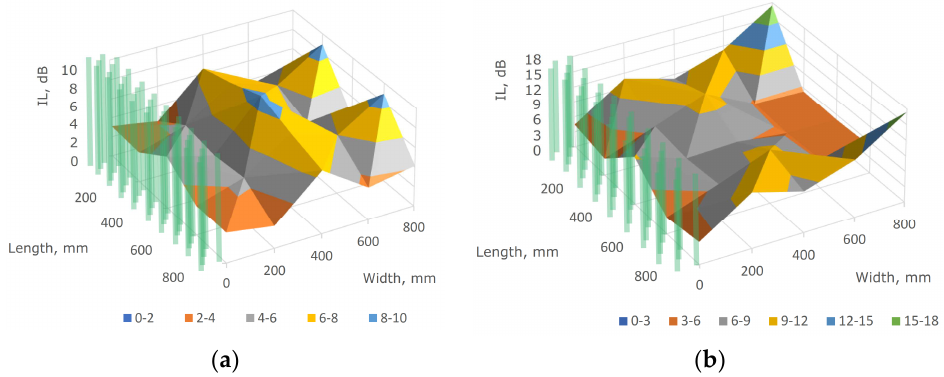
Figure 8. 3D view of the spatial distribution related to configuration 4, at 5 kHz ( a ) and 6.3 kHz ( b ). Distance between sound source and edge of barrier ( Xs ) is equal to 800 mm. Distance between receiver and edge of barrier ( Xr ) is variable and corresponds to 25 positions of a 200 × 200 mm grid.